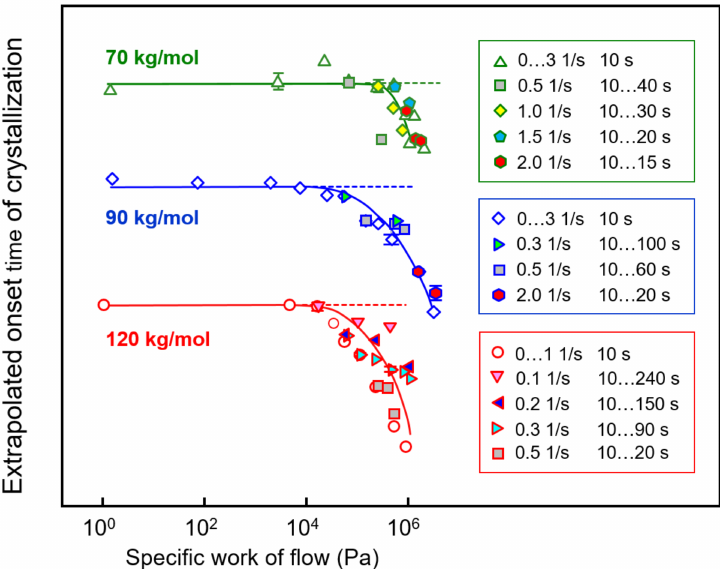
Figure 8. Extrapolated onset times of crystallization of PLLA of different molar mass of 70, 90, and 120 kg/mol (from top to bottom) as a function of the specific work of flow. The dashed lines indicate the zero-shear crystallization onset time. Error bars are shown for selected data only, being typically lower than the symbol size. Data from the sample with a molar mass of 576 kg/mol are not shown due to low